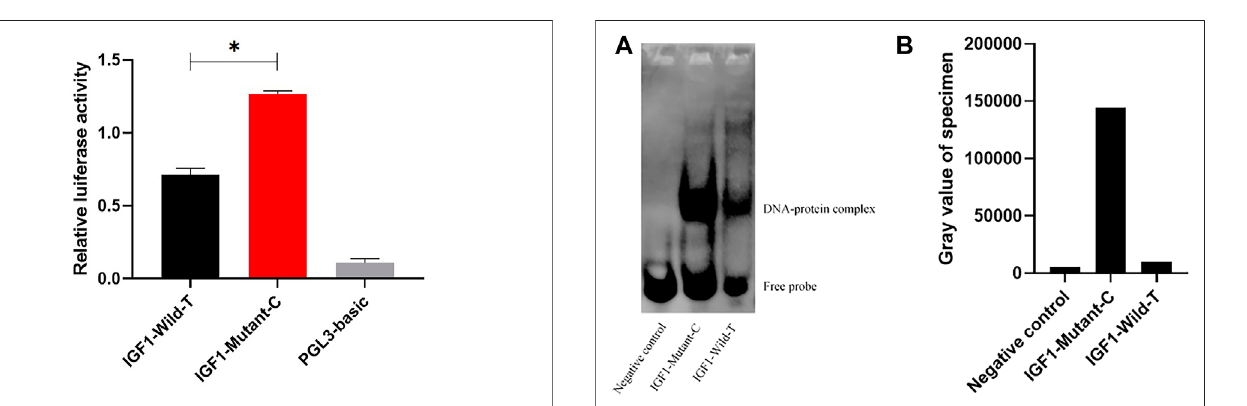
FIGURE 3 | Binding of different biological probes to ovarian nucleoprotein. (A) Binding of the probe to the nucleoprotein. These different probes were incubated with ovary nuclear extracts, and DNA – protein complexes were visualized by autoradiography. DNA – protein complex: DNA and transcription factor SP1 binding complex. (B) Sample gray